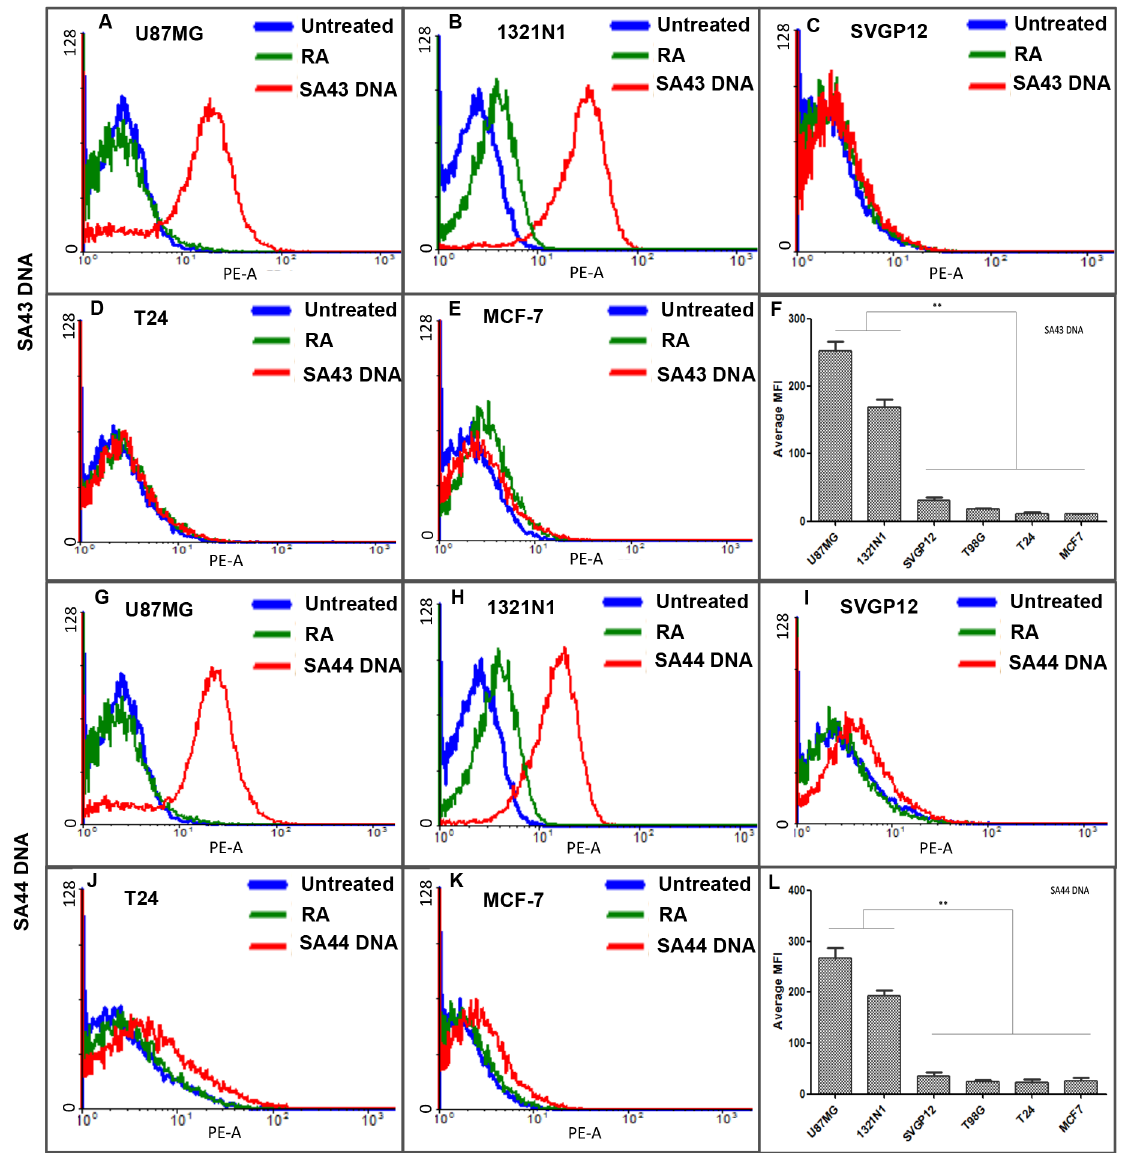
Fig 3. Representative flow cytometry profiles and comparative binding selectivity of the uptake of SA43 and SA44 DNA on various cell lines. Cy3 labelled SA43, SA44 and random aptamer (100 nM) were incubated separately on live U87MG, 1321N1, SVGp12, T24 and MCF-7 cells at 37°C (5% CO 2 ) for 90 minutes. Untreated cells were incubated with complete growth medium alone. The blue curve represents the background mean fluorescence intensity (MFI) of the untreated cells (control), and the green and red curve represents the MFI (uptake) of the cells treated with random aptamer and the lead aptamers respectively. A , B , C , D , and E represent uptake of SA43 on U87MG, 1321N1, SVGp12, T24 and MCF-7 cells respectively. G , H , I , J and K represent uptake of SA44 on U87MG, 1321N1, SVGp12, T24 and MCF-7 cells respectively. F and L are bar charts showing comparative binding selectivity of aptamer SA43 and SA44 across various cell types. The background MFI values for the random aptamer treated cells were subtracted. Statistical significance of the differences in MFI values of SA43 and SA44 between U87MG and 1321N1 versus SVGp12, T24, and MCF-7 confirm high binding selectivity of the aptamers for U87MG and 1321N1 cells ( ** = p < 0.01). No statistical difference was observed between U87MG and 1321N1 cells for both the aptamers ( p > 0.05; n = 3).